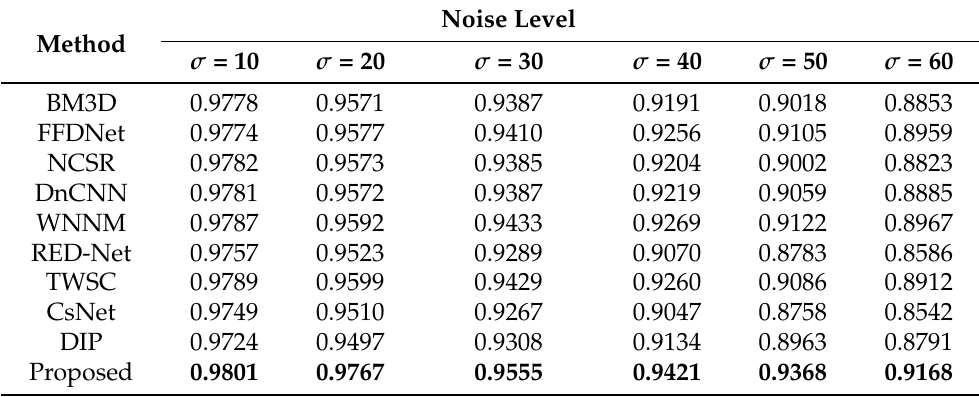
Table 17. Average FSIM results of different methods on 10 images in Urban100 with various noise